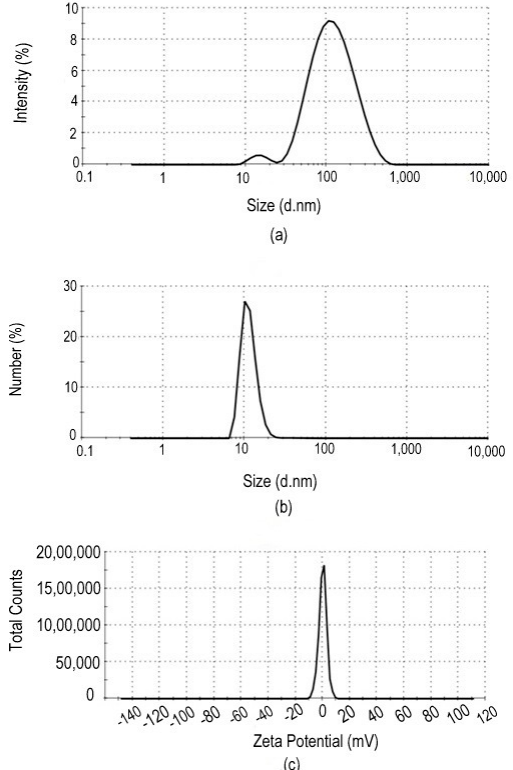
Figure 2. Particle size distribution of AgNPs with respect to ( a ) intensity, ( b ) number, and ( c ) Zeta Potential 0.45 (mV).